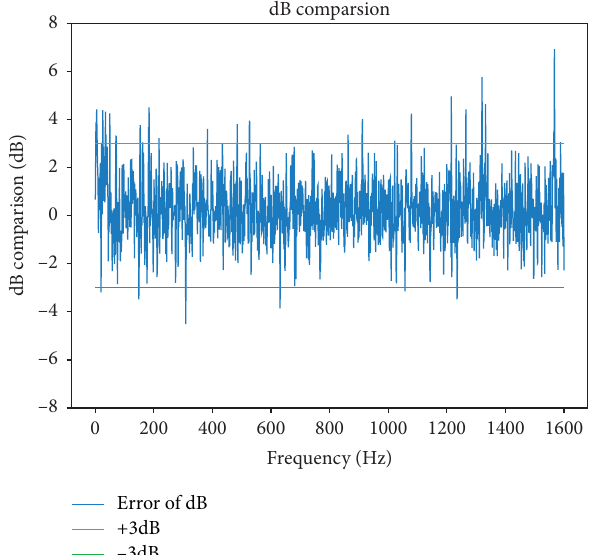
Figure 13: 3dB error value for the 2 nd response measurement point of the 8 th round after elastic-net regularization.